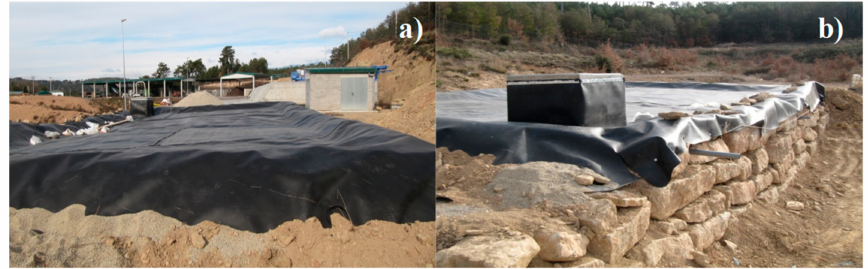
Figure 5. Experimental section image ( a ) “punctual” area, 199 m 2 , ( b ) “accumulated” area, 1 m 2 .